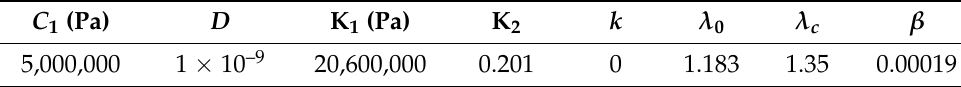
Table 1. Summary of ligament’s material